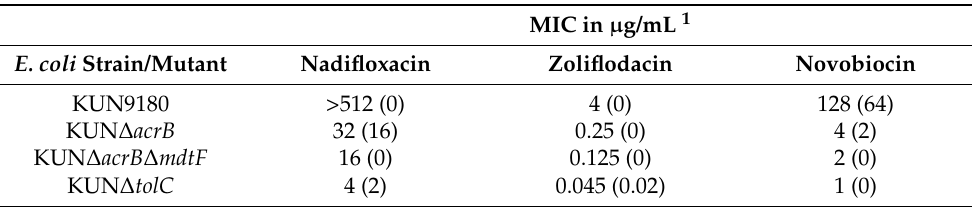
Table 1. Drug susceptibilities for which significant difference between acrB and tolC mutants of the MDR E. coli isolate KUN9180 were